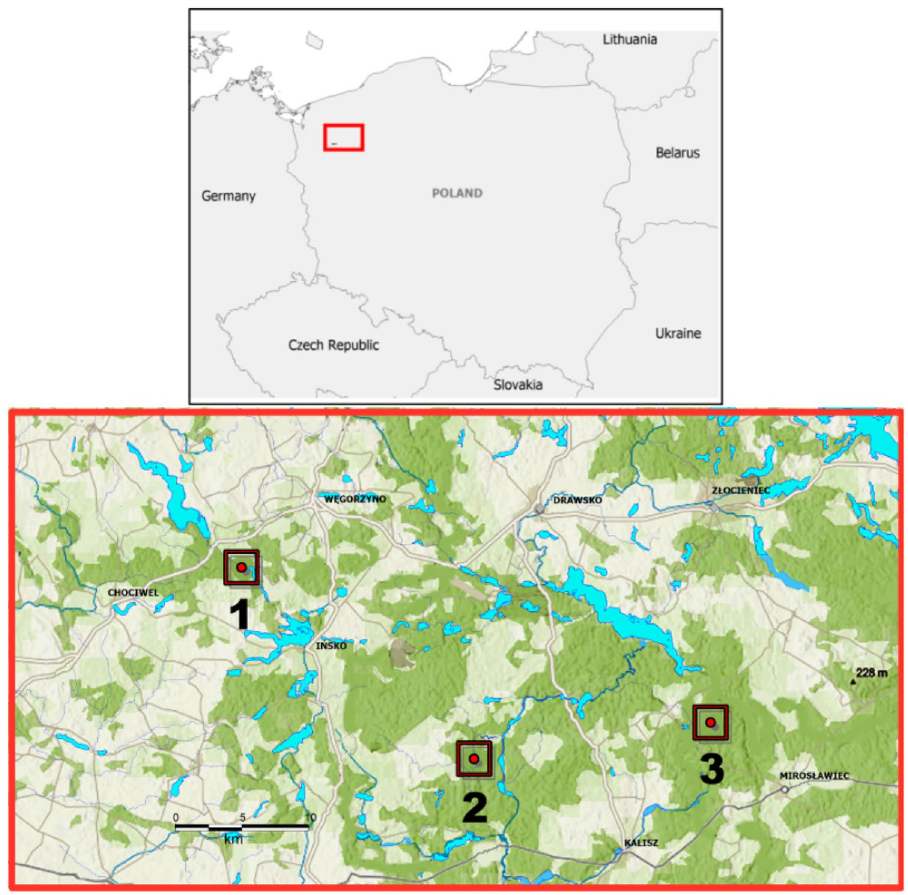
Figure 8. Release sites for the Eurasian lynx reintroduction programme in north-western Poland (1— adaptation enclosure in Dłusko, Ińsko Lakeland, 2—release centre in the Drawsko Forest District, 3—release centre in the Mirosławiec Forest District). Map developed in MapInfo Professional v11.0 (PitneyBowes,